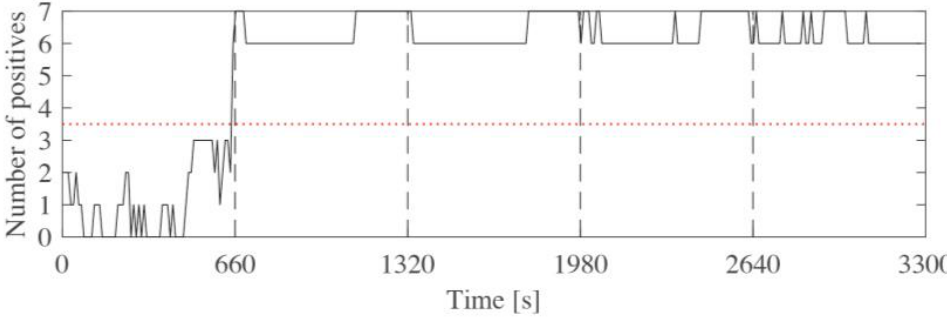
Figure 8. Cumulative number of positives detected.